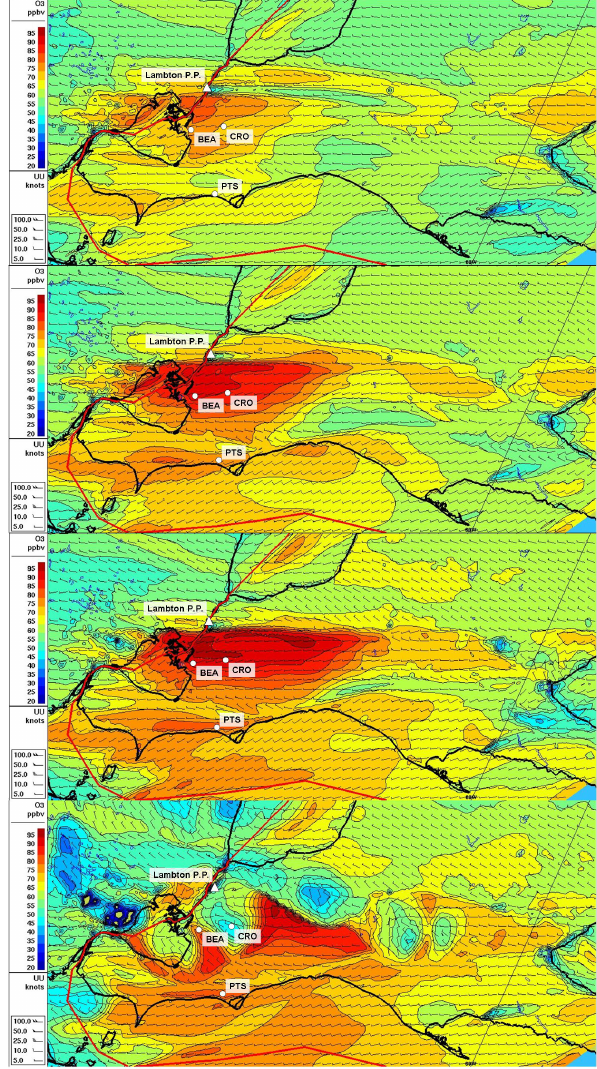
Fig. 16. Model-predicted surface ozone and wind fields for 27 June, (a) 16:00 UT (noon local time); (b) 17:00 UT (01:00p.m.); (c) 18:00 UT (02:00p.m.); (d) 19:00 UT (03:00p.m.). CRO: Cro- ton. BEA: Bear Creek. PTS: Port Stanley. Lambton P.P.: Lambton